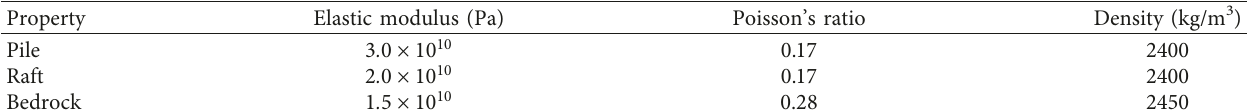
Figure 5: 3D view of the nuclear power plant system: (a) the components and peripheral dimensions of the model; (b) cross-sectional view of the model. Table 6: Calculated parameters of the pile, raft, and bedrock.